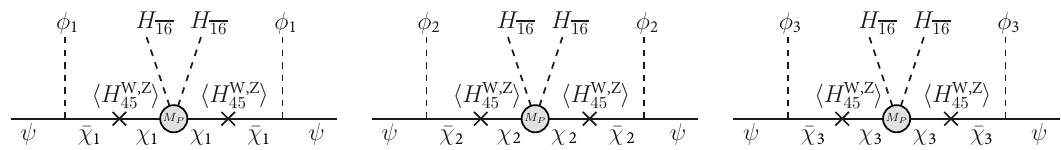
Figure 3. Diagrams coupling to H